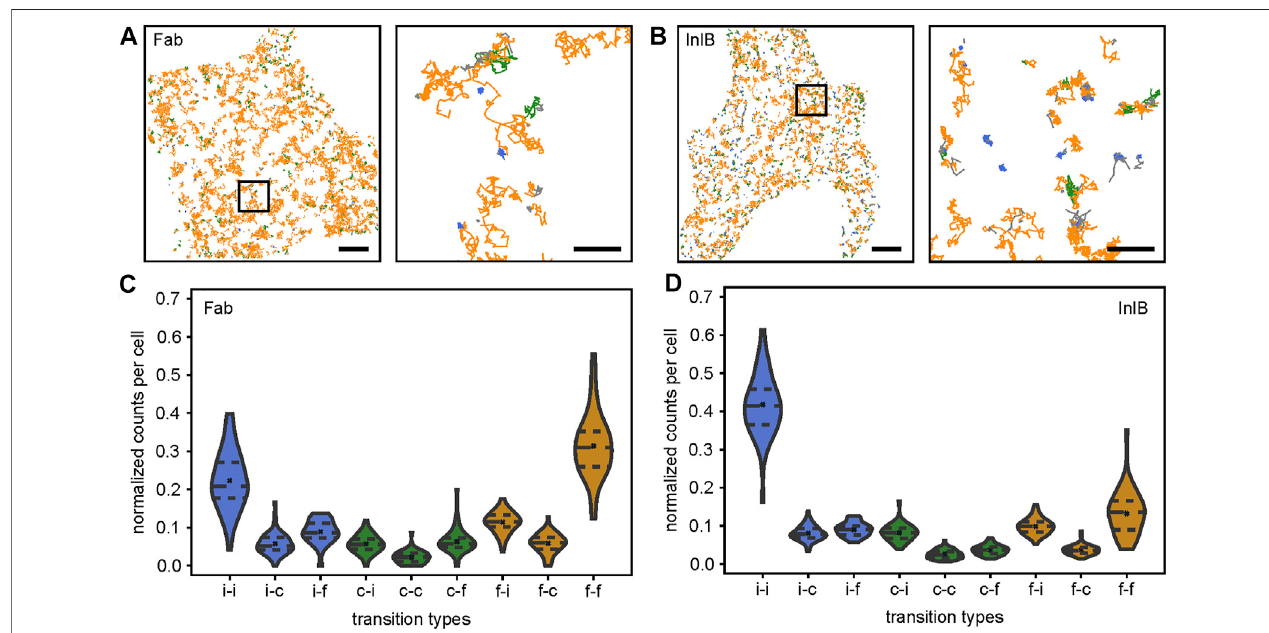
FIGURE2 | Single-moleculetrajectories and quanti fi cation oftransitionswithintrajectories.Single-moleculetrajectories of (A) Fab-bound and (B) InlB-bound MET receptorswithinexemplarycells.Diffusionstatesofsegmentsarehighlightedincolors(free:orange,con fi ned:green,immobile:blue).Highlightedregionsintheoverview imagesare shown as zoom-ins (right). In the zoom-ins only trajectories showing at least onetransition are displayed. Scale bars 5 μ m, zoom-ins 1 μ m. Violin plots ofthe ninedifferentdiffusionstatetransitionsbetweensegmentswithintrajectoriesin (C) Fab-boundand (D) InlB-boundcells(i (cid:1) immobile,c (cid:1) con fi ned,f (cid:1) free).Counts are normalized to one per cell. For each condition 60 cells were analyzed. Dashed lines mark the quartiles, crosses correspond to the